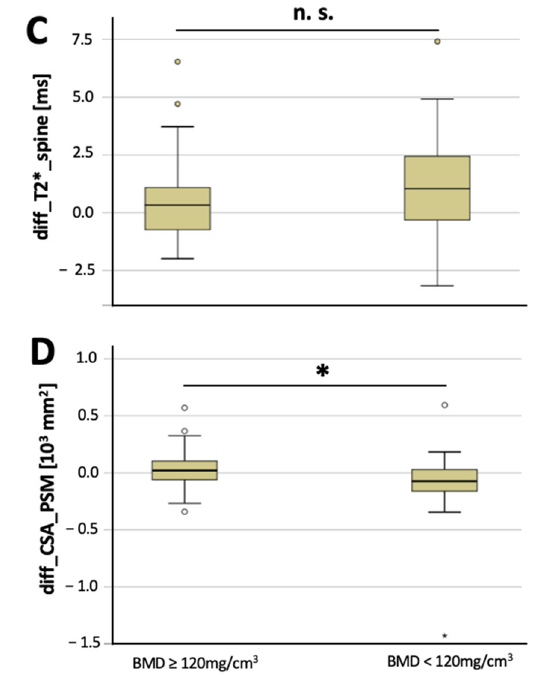
Figure 2. Longitudinal changes over 6 months in non-osteoporotic/osteopenic patients ( ≥ 120 mg/cm 3 ) and in osteoporotic/osteopenic patients (BMD < 120 mg/cm 3 ). Changes in vertebral PDFF ( A , diff_PDFF_spine), changes in PSM PDFF ( B , diff_PDFF_PSM), changes in vertebral T2* values ( C , diff_T2*_spine) and changes in CSA of the PSM ( D , diff_CSA_PSM) between baseline and 6-month follow-up (asterisks indicate significant difference). Boxplots: ◦ = outlier; * = extreme outlier.